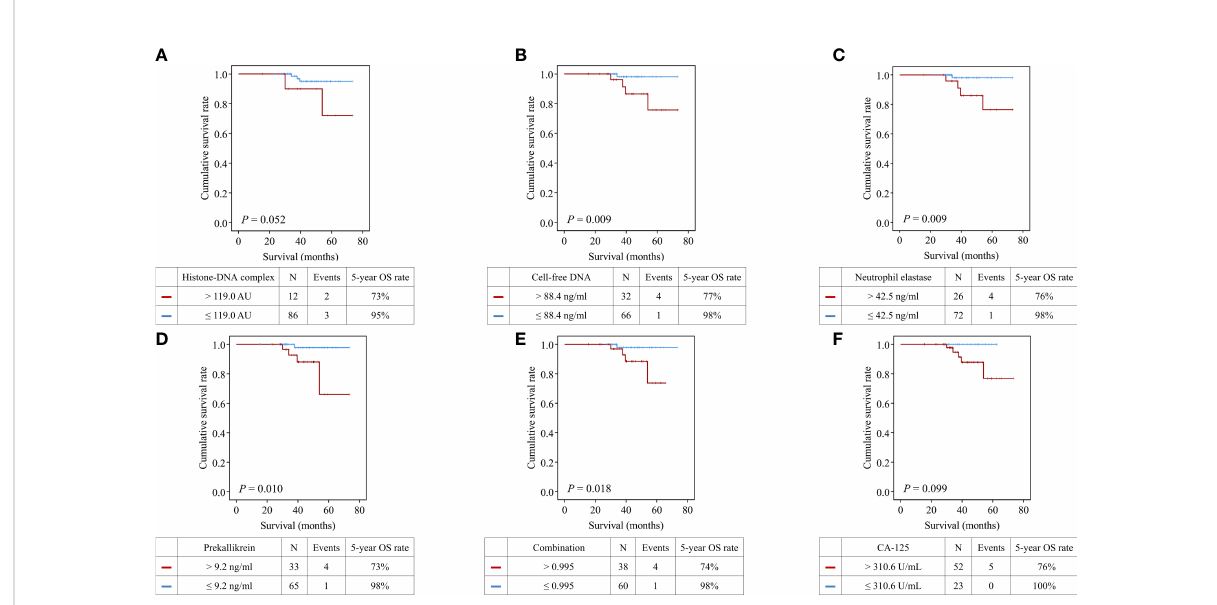
FIGURE 3 Comparisons of overall survival between patients with high and low levels of the markers. (A) Histone − DNA complex; (B) Cell-free DNA; (C) Neutrophil elastase; (D) Prekallikrein; (E) Logistic regression-based model of the four markers; (F)